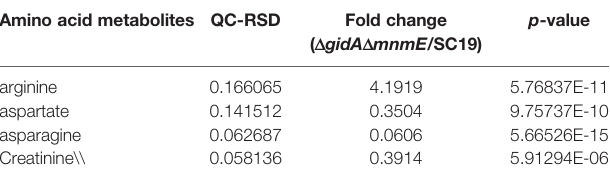
( D gidA D mnmE /SC19)